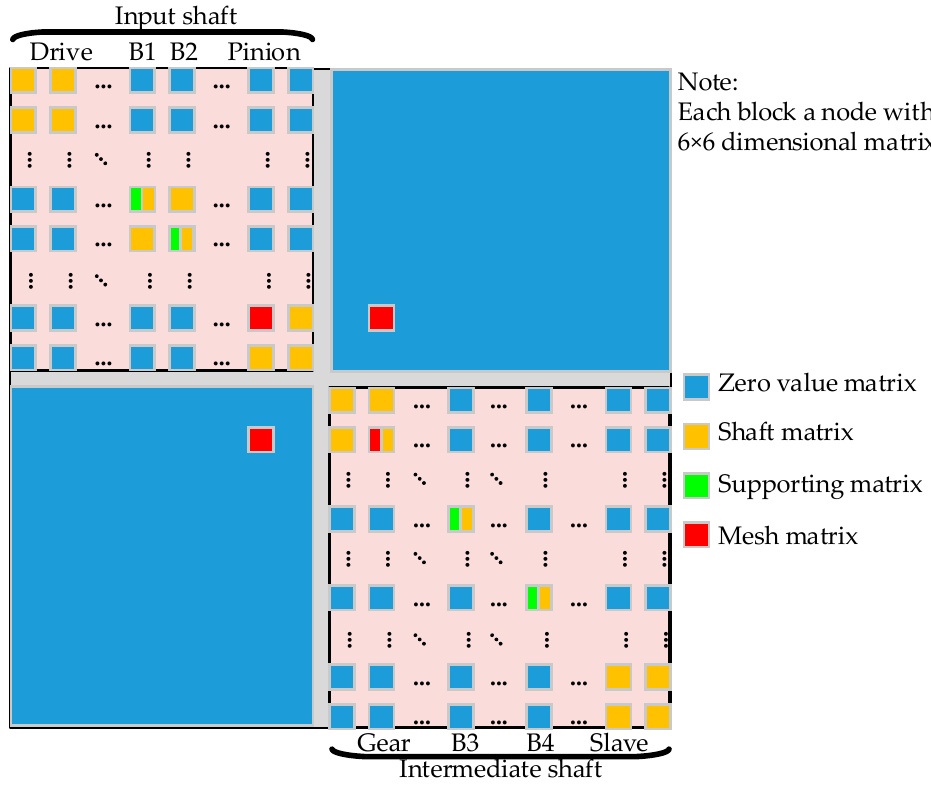
Figure 17. The schematic of the grouping of the system stiffness matrix and damping matrix. The damping matrices of the input shaft-bevel pinion structure (with footnote “1”) and the damping matrices of the intermediate shaft-bevel gear structure (with footnote “2”) are described